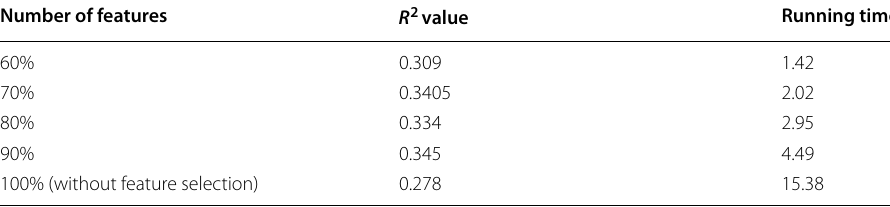
Table 3 QSAR-RFR(PCA) simulation results on ECFP_6 dataset Number of features